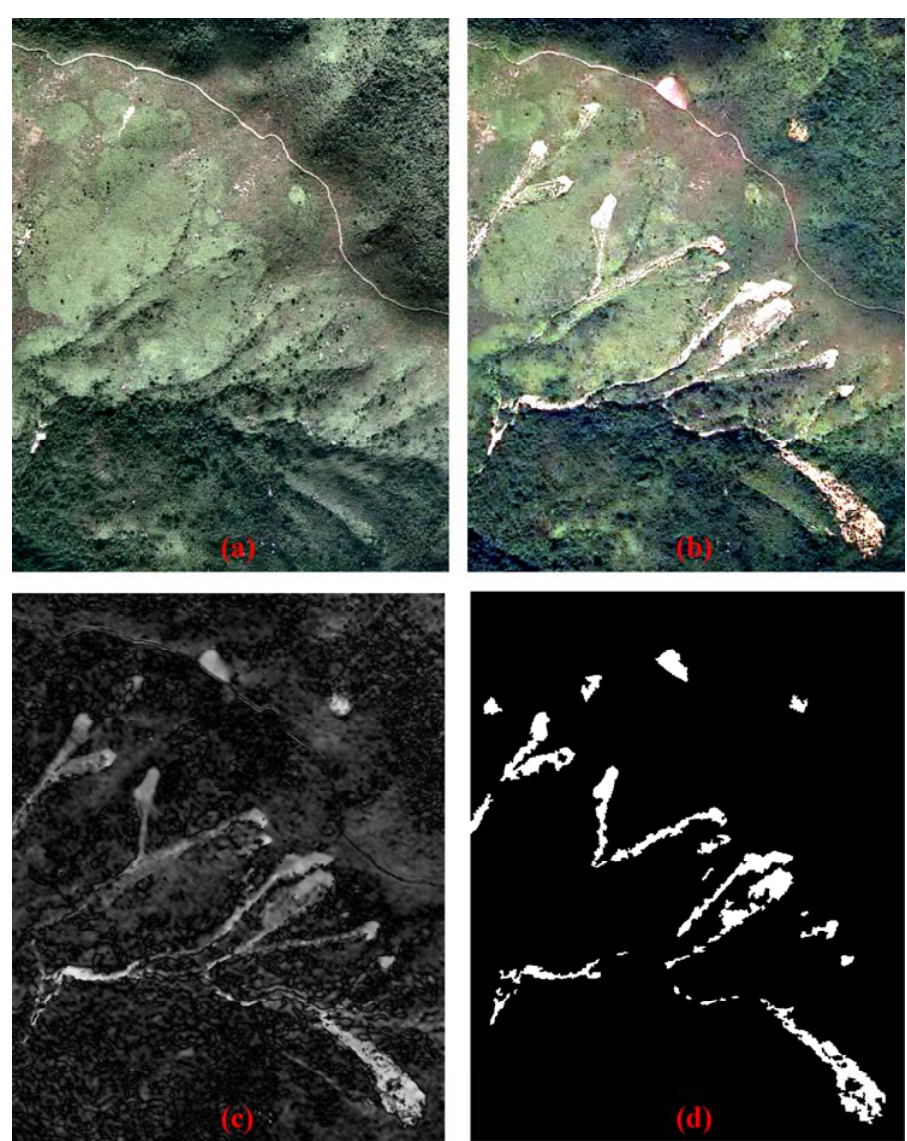
Figure 6. Image of landslide area in Lantau Island, Hong Kong, China: ( a ) pre ‐ event image captured in April 2007, ( b ) post ‐ event image captured in July 2014, ( c ) corresponding CMI based on the proposed approach, and ( d ) reference map of the changed area.